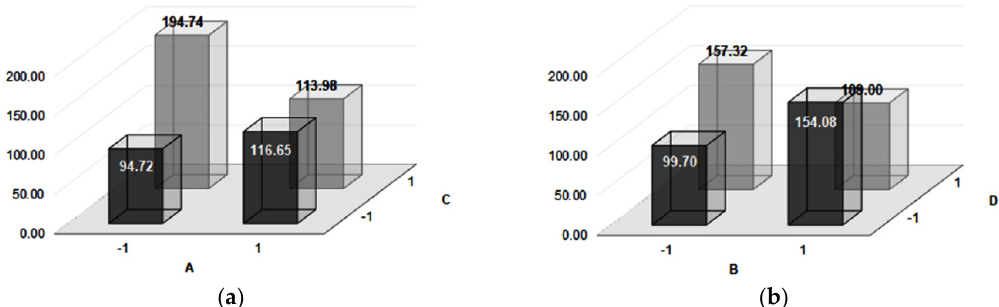
Figure 5. Analysis of interactions with significant effects with respect to abrasive wear. X ‐ axis represents the two levels of A ‐ factor (figure (a)) and the two levels of B ‐ factor (figure (b)). Y ‐ axis represents the two levels of C ‐ factor (figure (a)) and the two levels of D ‐ factor (figure (b)). Z ‐ axis represents the effect of each possible combination: ( a ) interaction AC; ( b ) interaction BD.